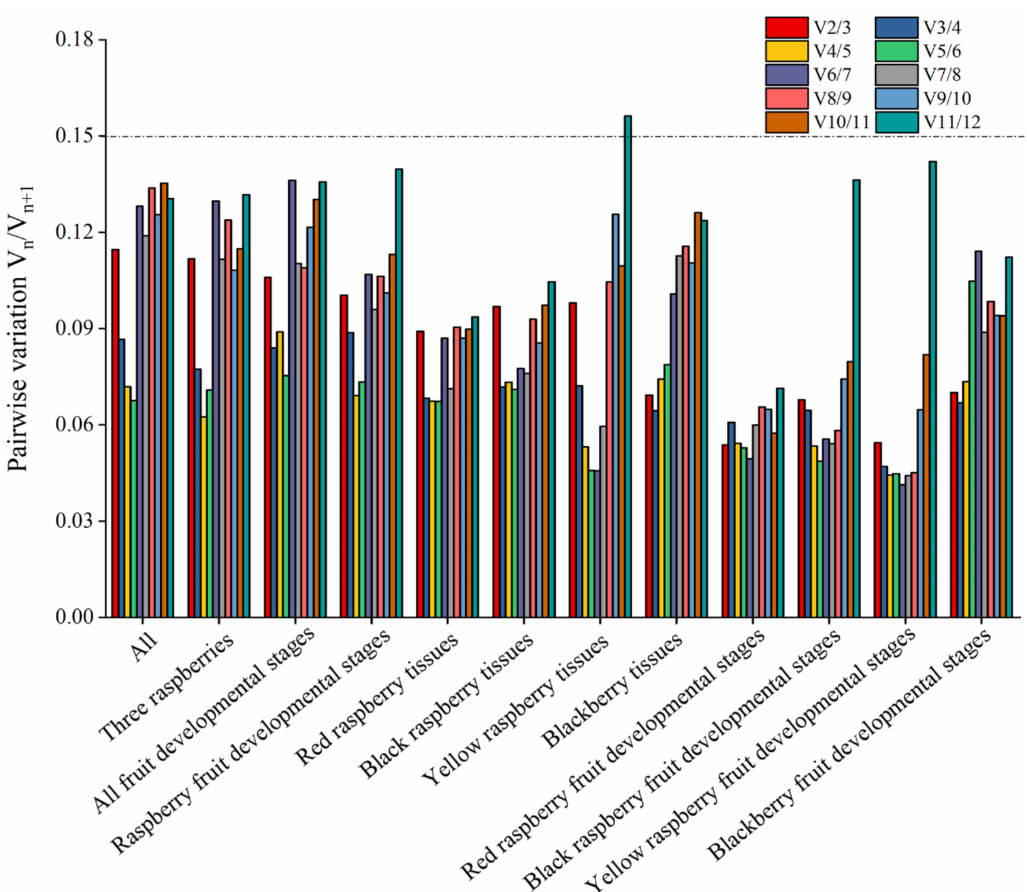
Figure 3. geNorm analysis of paired variation V values of 12 candidate reference genes. Vn/Vn + 1 values are used to determine the optimal number of reference genes. The cut-off value to determine the optimal number of reference genes for RT-qPCR normalization is